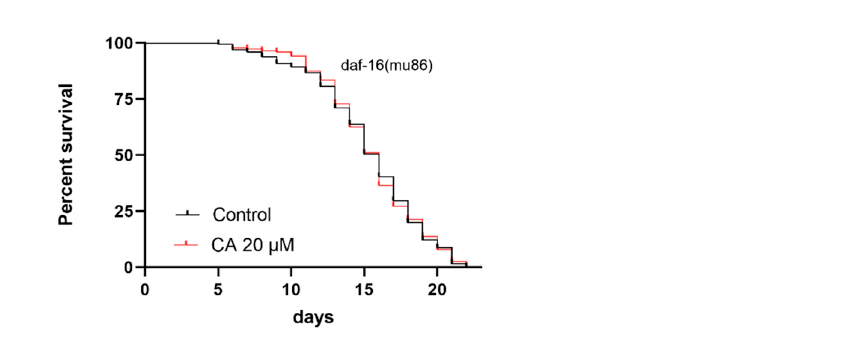
Figure 9. Effect of CA on the lifespan C. elegans with a functional mutation in daf-16. Worms were raised at 20 ◦ C on NGM OP50 plates without (control) or with CA (20 µ M). The CA 20 µ M group had almost the same lifespan as the control group ( n > 216 worms per group, p > 0.05). Table 5. Effect of CA on the mean lifespan of CF1038 daf-16(mu86) .